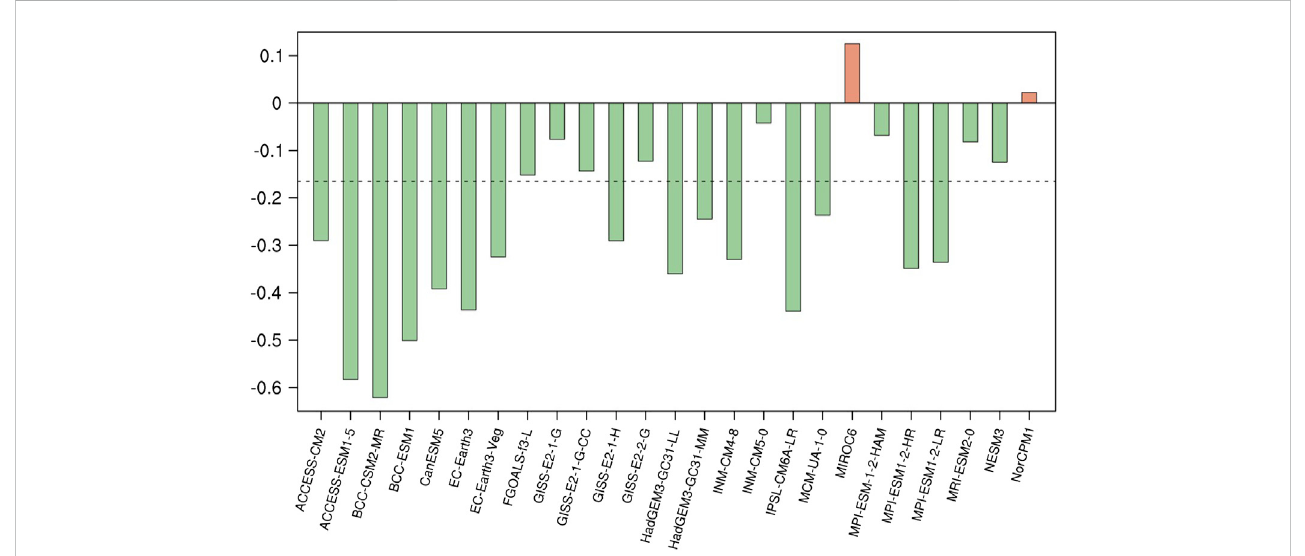
FIGURE 12 Correlationsof theDJFM (0)-averaged NADI with following MJJAWPI derived from theCMIP6 model simulations.The horizontal dashed lines show the 90% con fi dence levels.